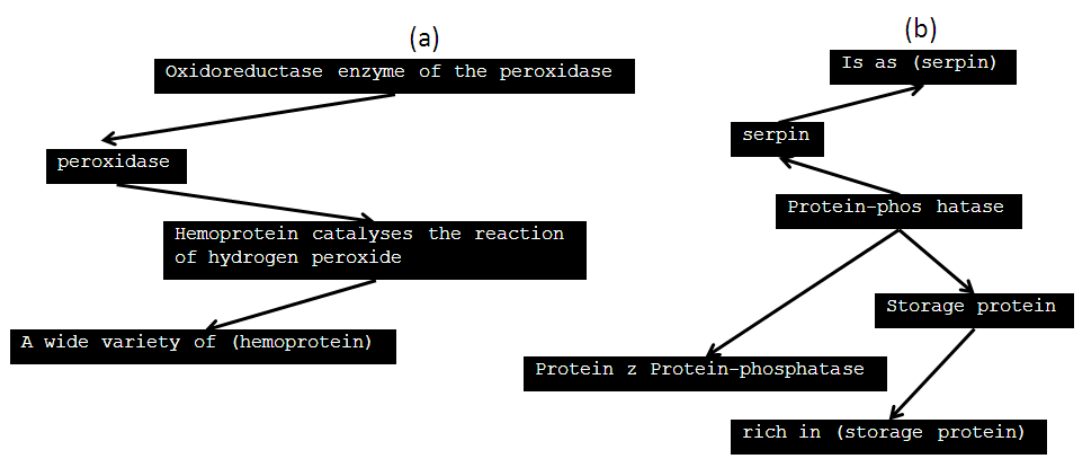
Figure 8: Detailed networks used for biological validation of concept relationships. (a). True- positive relationship around the concept of peroxidase. (b). False-positive relationship around the concept of protein phosphatase.